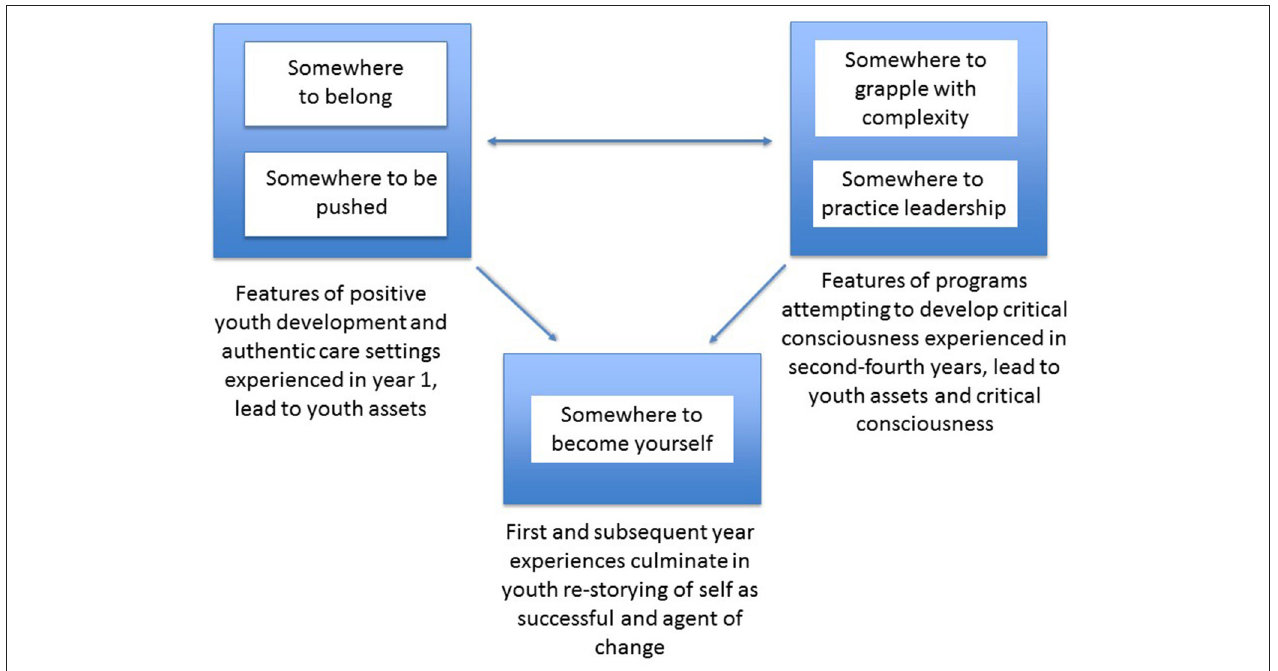
FIGURE 1 | Program elements can be considered affordances for positive youth development for interns, provided initially by staff and later by returning interns themselves.